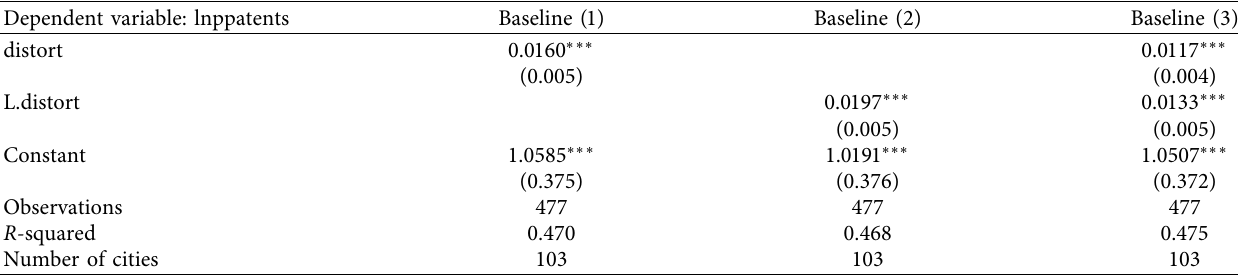
Table 4: Baseline regression of 103 key